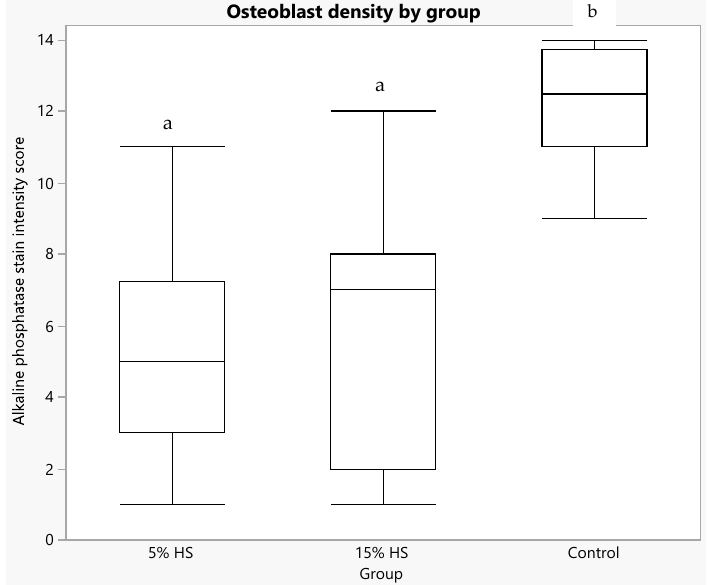
Figure 13. Box plot of alkaline phosphatase stain density score at the humerus epiphysis for each diet group. Higher scores equate to greater density of osteoblasts. Boxes depict: 75th percentile (upper edge), 50th percentile/median (middle line), 25th percentile (lower edge) and whiskers (maximum and minimum values). Main effect of group, p < 0.0001. Boxes not sharing letter superscripts indicate significantly different values.